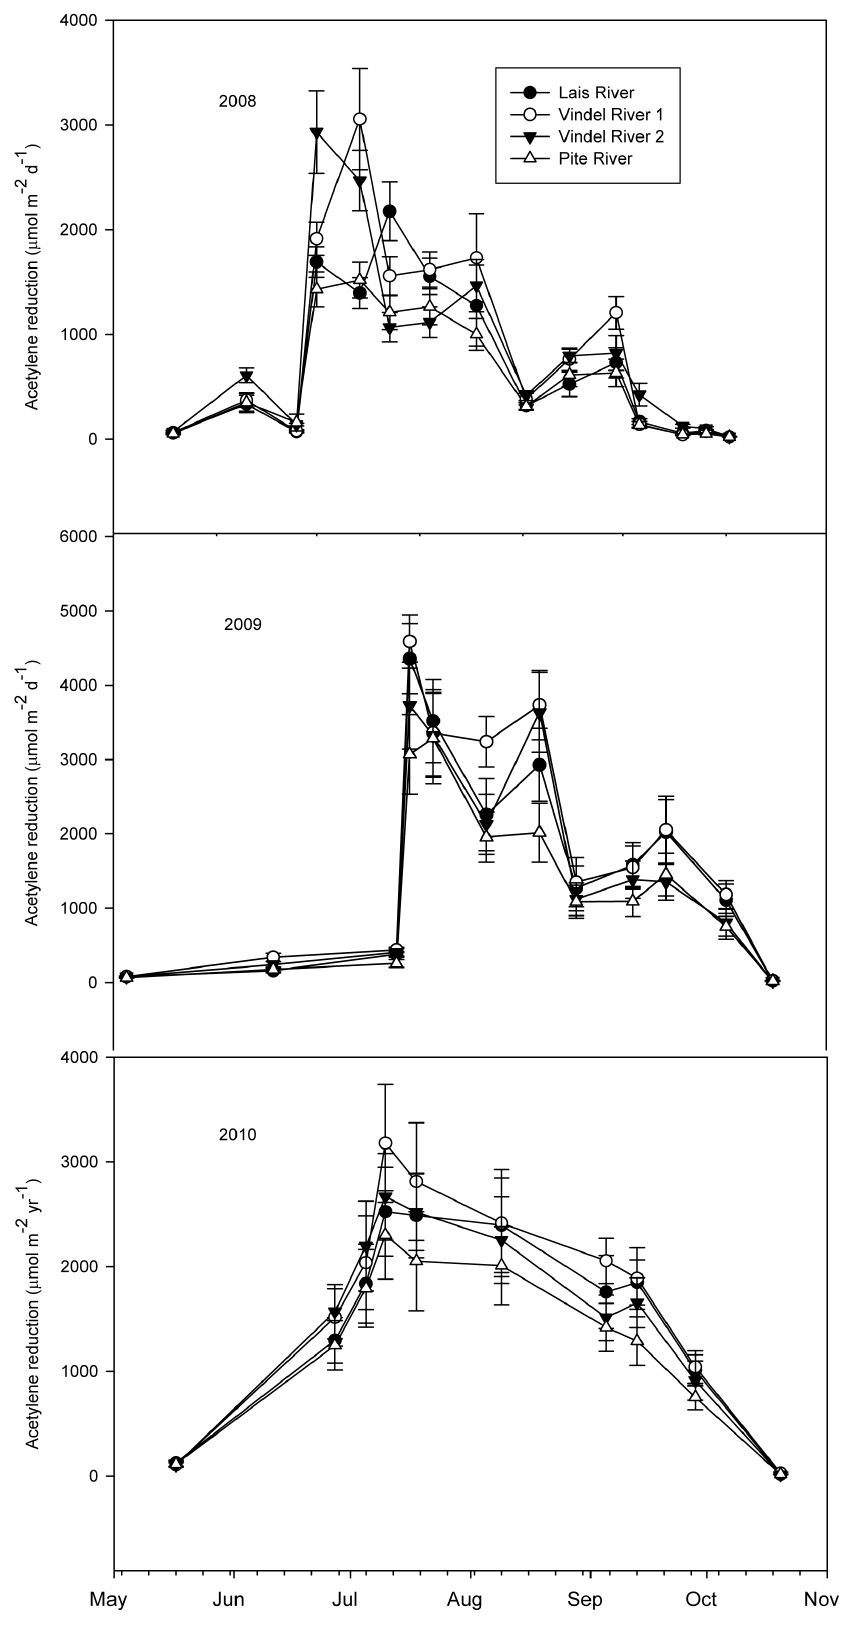
Figure 4. Nitrogenase activity in four intensively sampled alluvial meadow sites along three major rivers (Vindel, Pite, and Lais) in Northern Sweden assayed from May 2008 to November 2010. Each data point represents average nitrogenase activity (acetylene reduction)